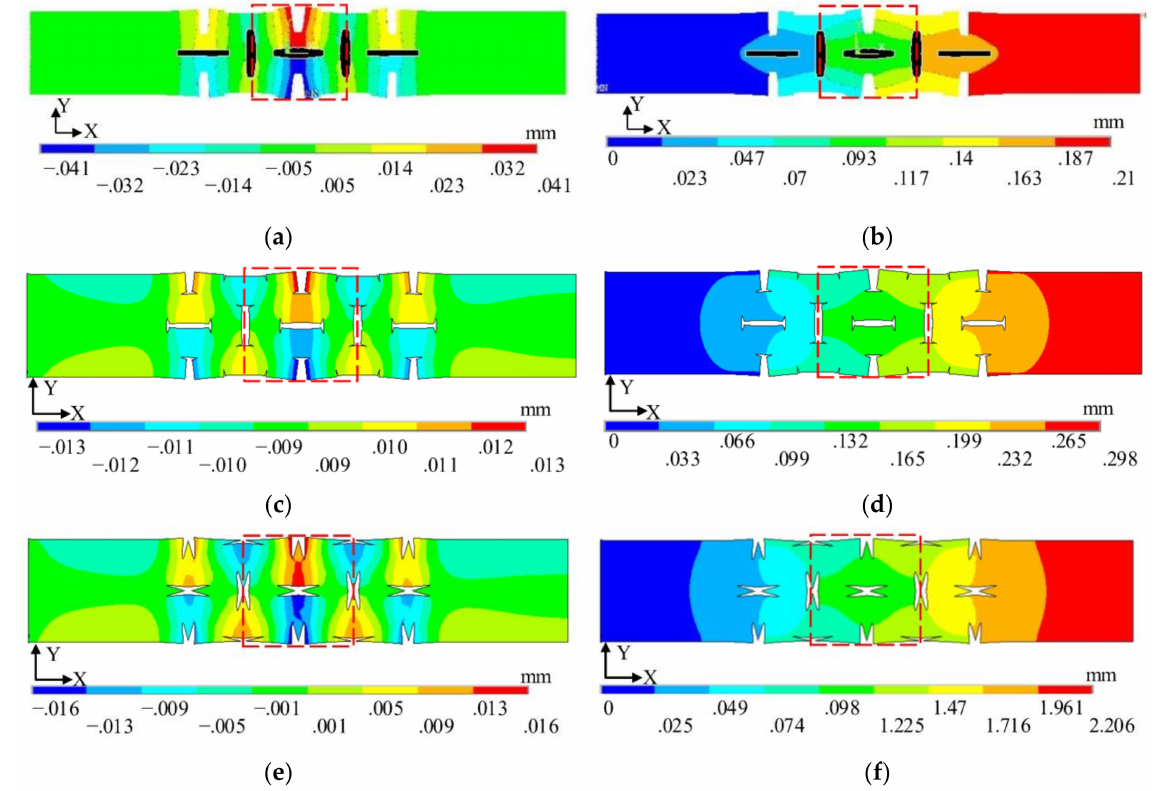
Figure 5. Contour maps of horizontal ( u x ) and vertical ( u y ) components of displacement field in different cells: ( a ) X-direction displacement of internally concave hexagonal, ( b ) Y-direction displacement of internally concave hexagonal, ( c ) X-direction displacement of H-shaped, ( d ) Y-direction displacement of H-shaped, ( e ) X-direction displacement of star-shaped, and ( f ) Y-direction displacement of star-shaped NPR periodic cell structures.